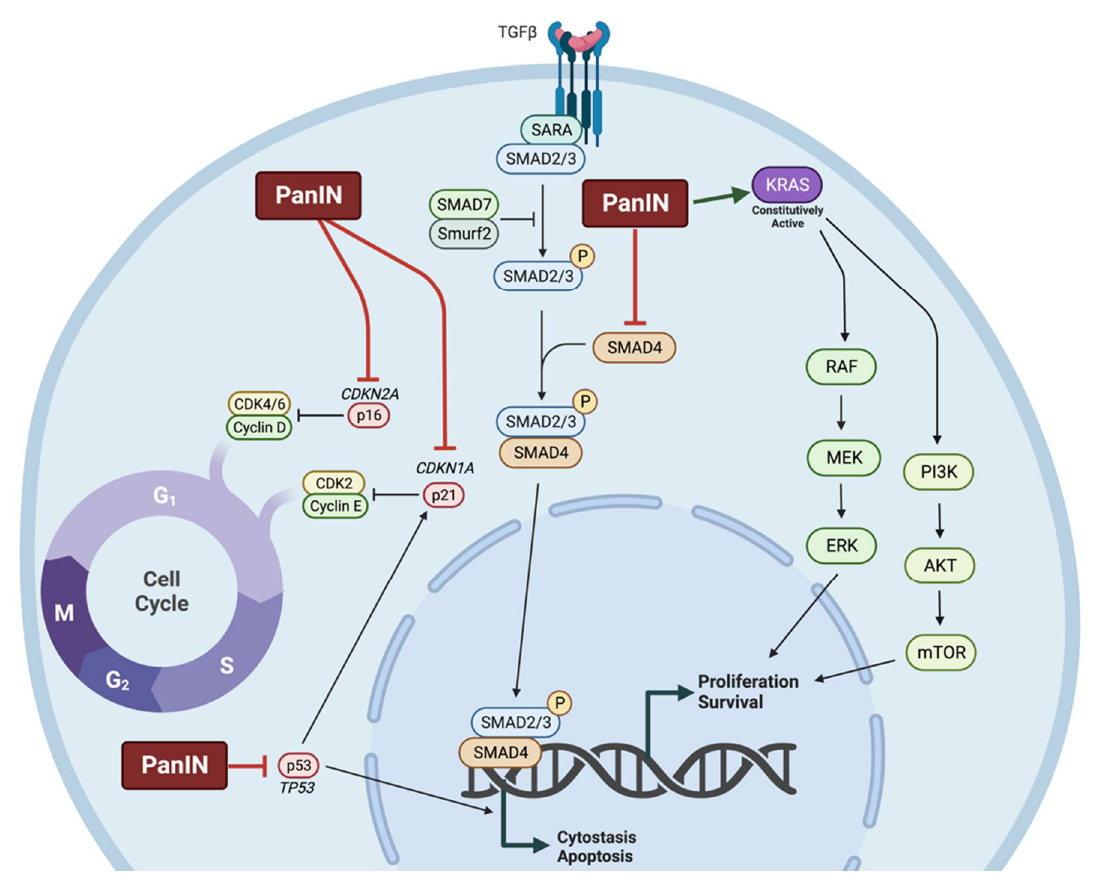
Figure 2. Cell signalling pathways disrupted in pancreatic intraepithelial neoplasia (PanIN). Pan- creatic intraepithelial neoplasia is characterized by inactivating mutations in tumour suppressor CDKN2A and CDKN1A , encoding p16 and p21, leading to increased progression from G 1 into S-phase of the cell cycle. Additionally, more than 90% of lesions have constitutively active KRAS mutations leading to overactivation of RAF-MEK-ERK and PI3K-AKT-mTOR signalling, resulting in enhanced proliferation and survival. Furthermore, PanIN interrupts downstream TGFβ signalling through SMAD4 inhibition leading to decreased apoptosis and cytostasis. Lastly, PanIN frequently results in loss-of-function mutations in the TP53 gene encoding the tumour suppressor